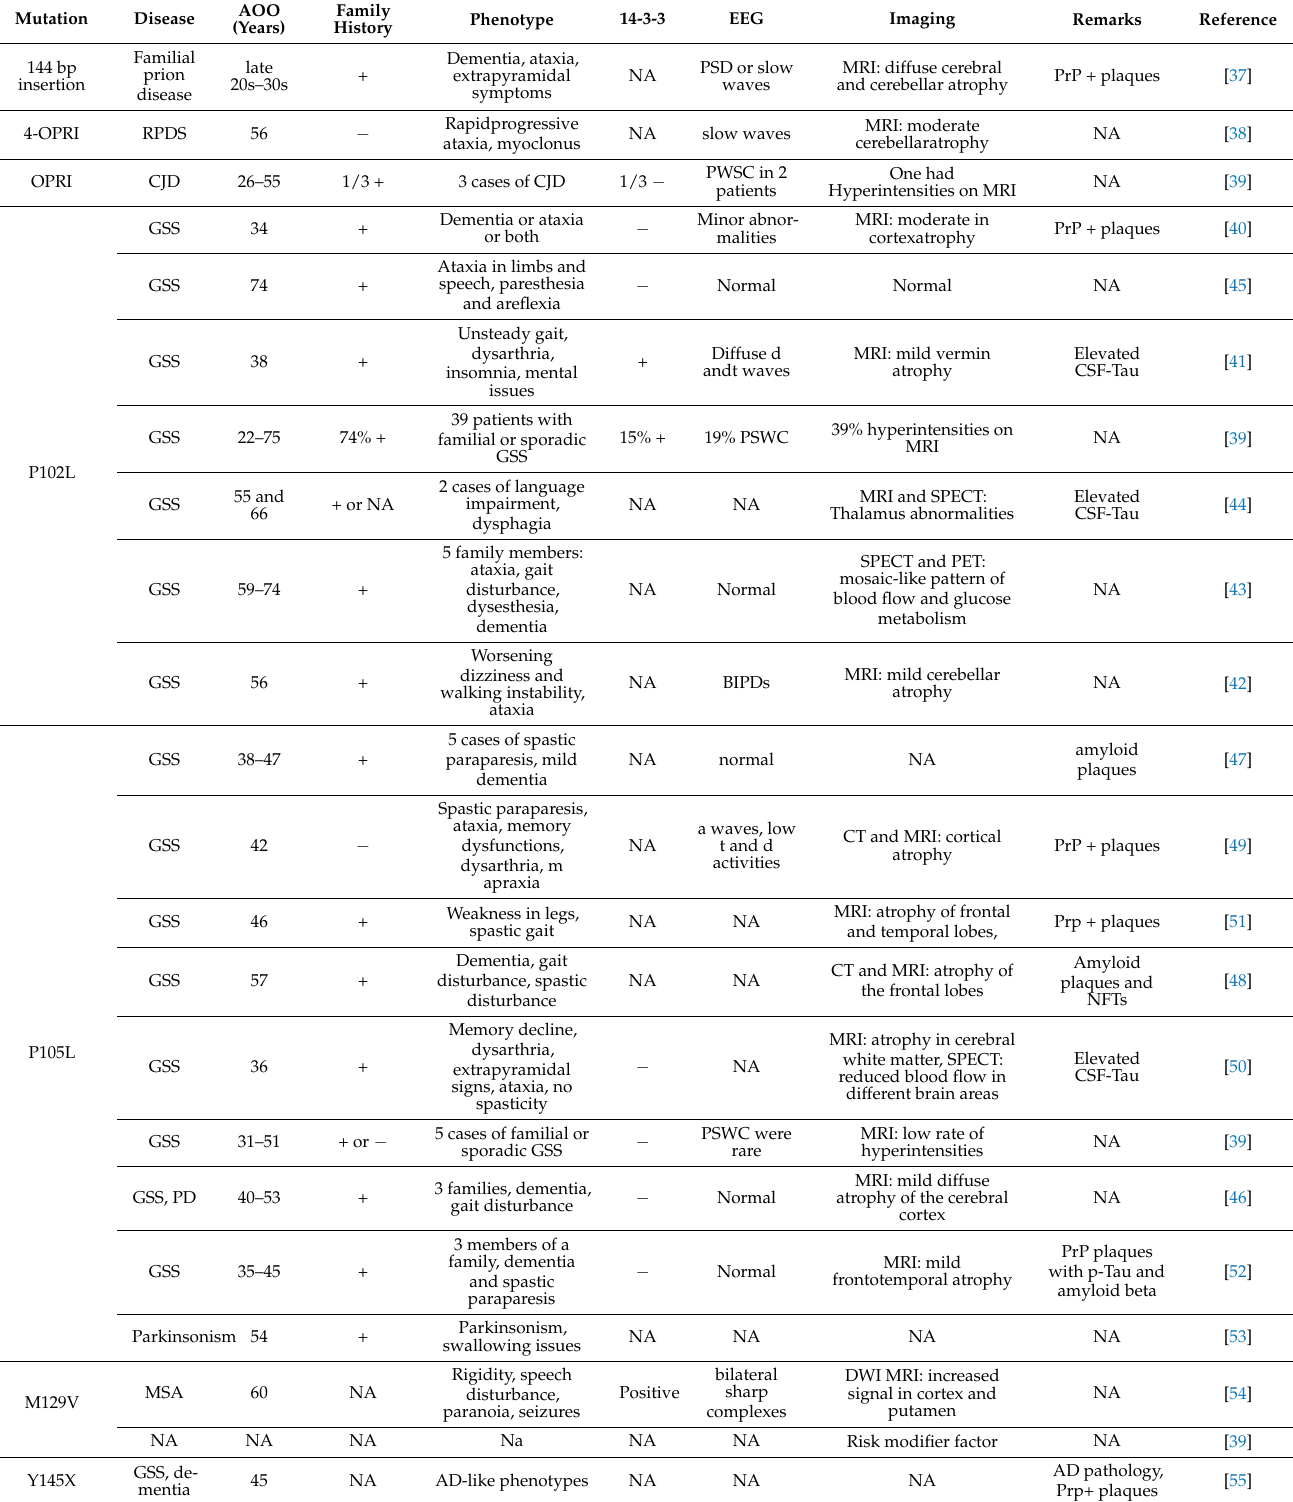
Table 2. Japanese cases of prion mutations (AOO means age of onset, hm means